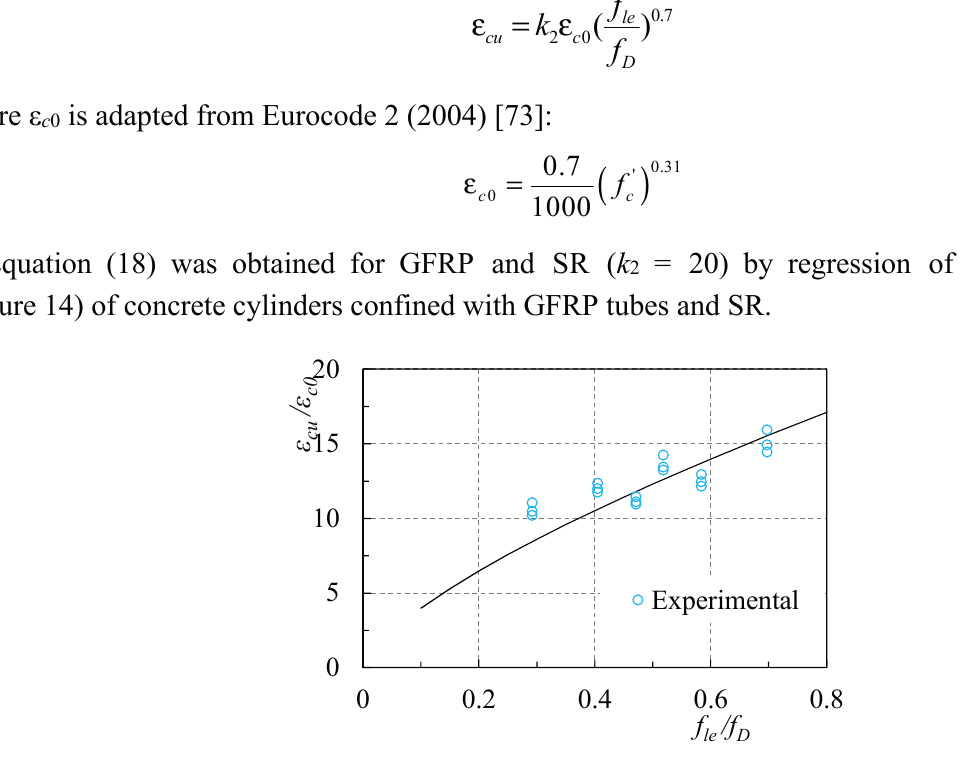
Figure 14. Relationship between ε cu / ε c0 and f le /f D of concrete cylinders confined with GFRP and